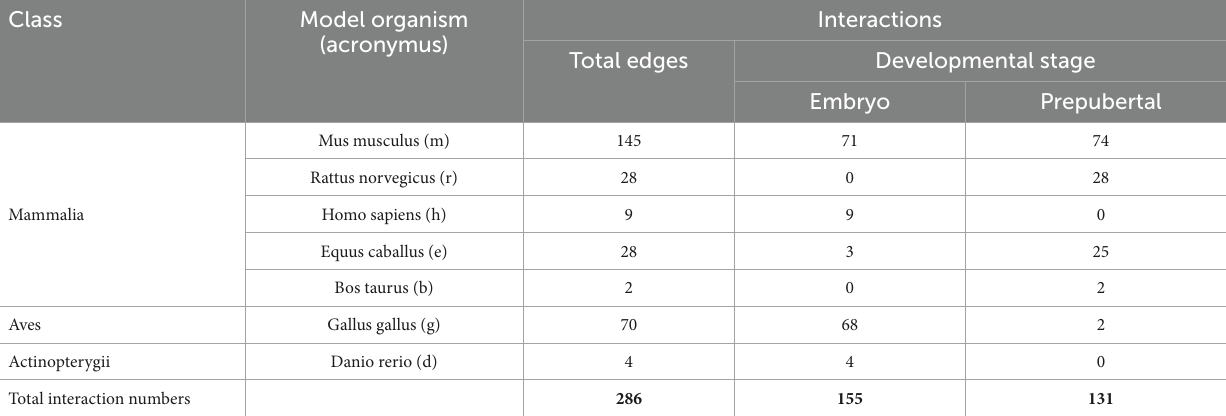
TABLE 1 Classification of interactions collected from literature and classified according to the organism model and the stage of development (embryo or prepubertal stage). Class Model organism